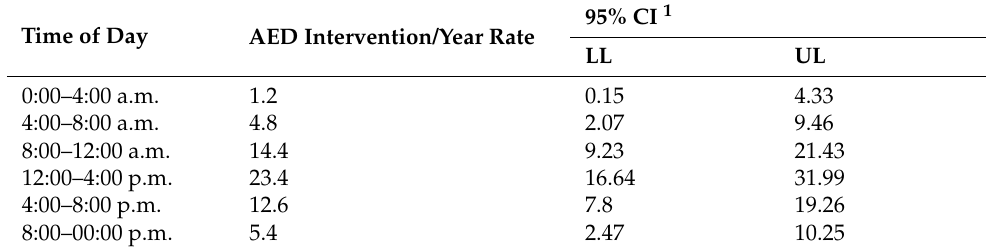
Table 7. Frequency of AED interventions by the time of